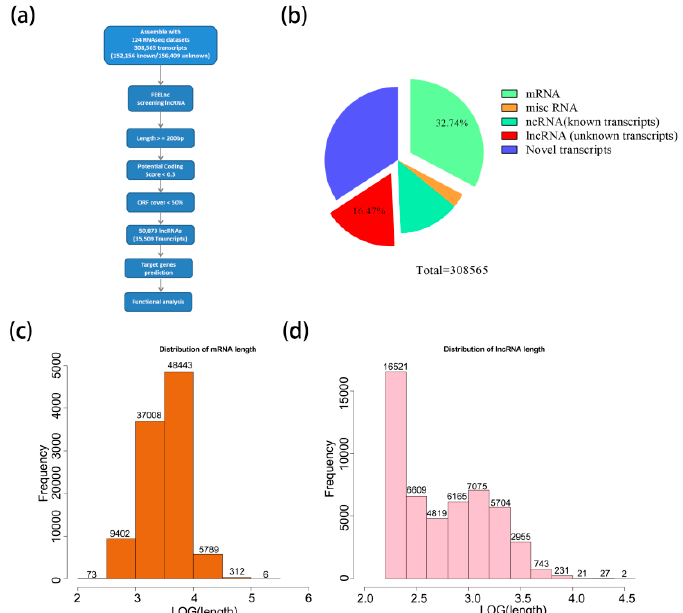
Figure 1. Identification and characterization of novel long non-coding RNAs (lncRNAs) in peanut. ( a ) Flow diagram of the bioinformatics pipeline for the identification of lncRNAs in peanut. The potential coding scores were calculated by FEELnc. ( b ) The proportion of lncRNA in all transcripts. ( c , d ) Length distribution of mRNA and lncRNA.